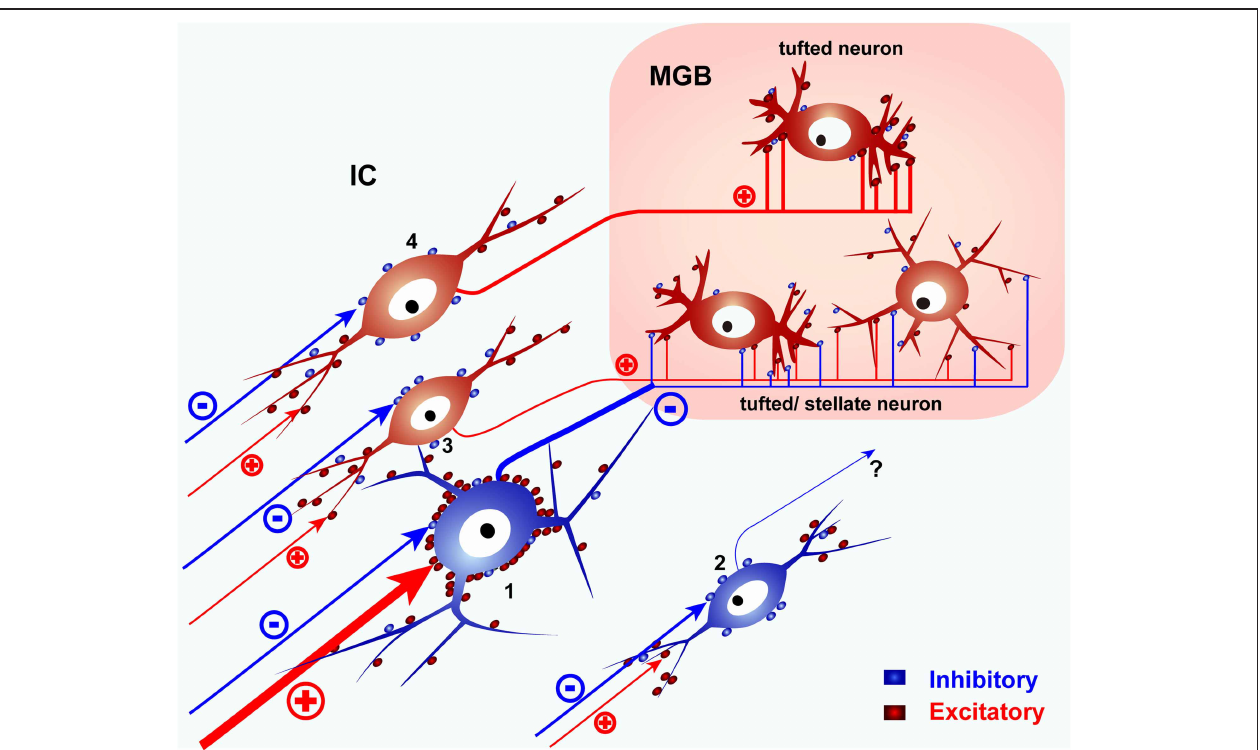
FIGURE 6 | A schematic diagram of the basic IC circuit. LG neurons (1) receive strong excitatory inputs on their somata, send their axons to the MGB, and presumably inhibit tufted or stellate neurons in the MGB. SG neurons (2) do not target MGB. Glutamatergic neurons (3, 4) project to the MGB but lack the dense VGLUT2 axosomatic inputs. Glutamatergic neurons with small terminals (3) co-innervate tufted or stellate neurons with